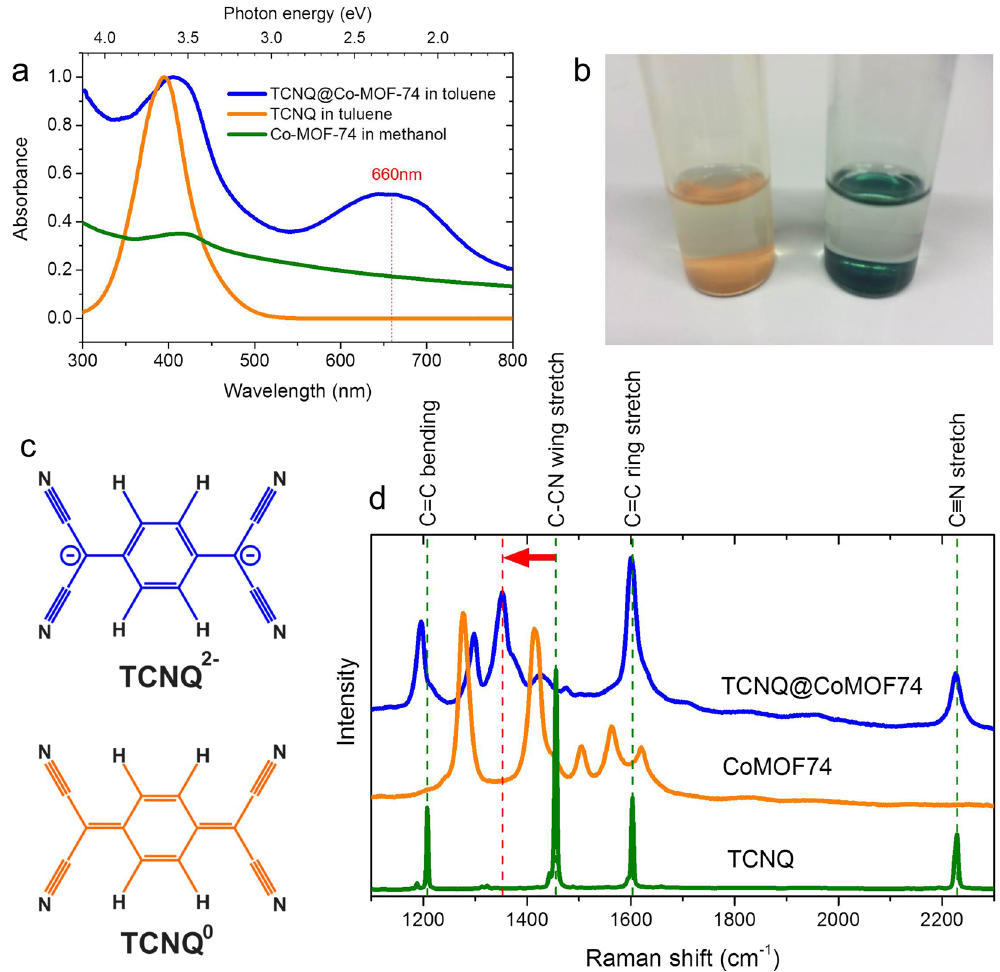
Figure 3. ( a ) Absorption spectra of TCNQ, Co-MOF-74 and TCNQ@Co-MOF-74 nanocrystals. ( b ) A photograph of the glass vials containing Co-MOF-74 (left) and TCNQ@Co-MOF-74 (right) nanocrystals, both in methanol. ( c ) Diagrams for neutral TCNQ 0 (bottom) and divalent TCNQ 2 − (top). ( d ) Raman spectra of TCNQ, Co-MOF-74 and TCNQ@Co-MOF-74 microcrystals collected at 633 nm laser wavelength. The dashed vertical lines in green are the frequencies for the four major Raman lines of TCNQ 0 , while that in red is associated to the frequency for red-shifted C-CN wing stretch mode of TCNQ 2 − in the Co-MOF-74.